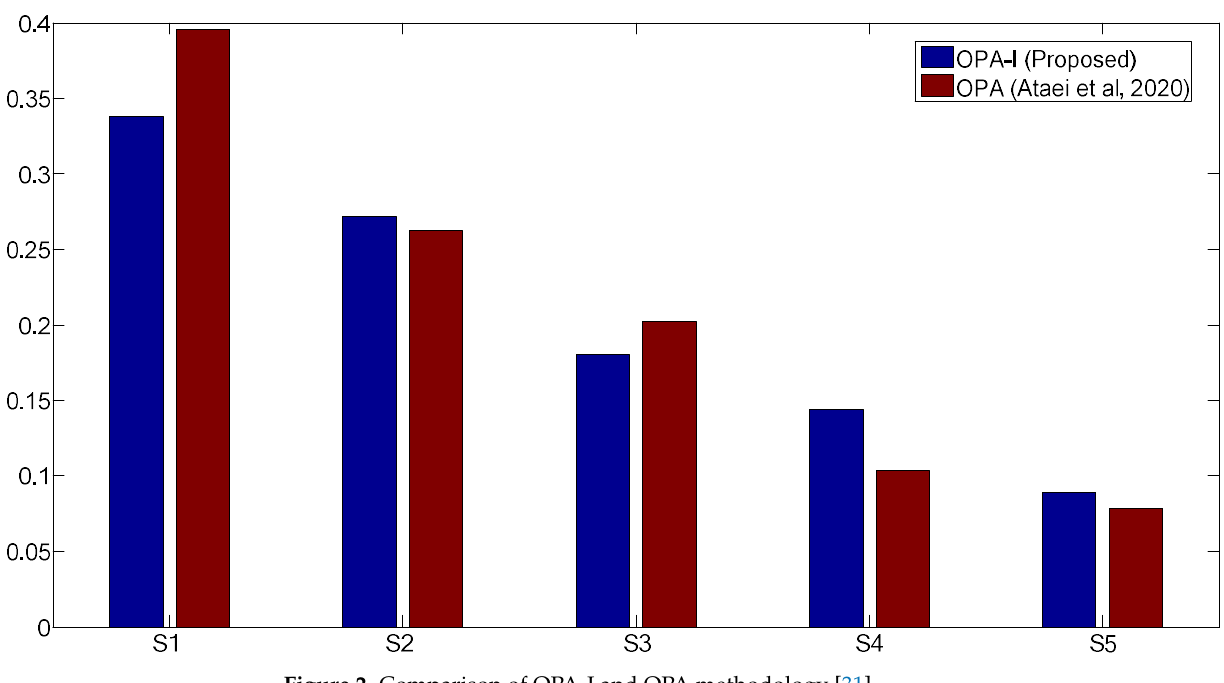
Figure 2. Comparison of OPA-I and OPA methodology [31].